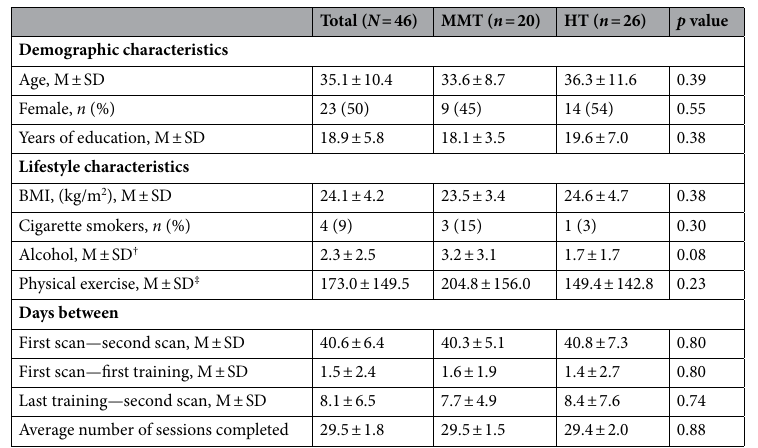
Table 1. Participant demographics, lifestyle characteristics and scanning intervals. † Serving sizes of wine (150 ml) or beer (350 ml) per week. ‡ Minutes per week. MMT Mindfulness Meditation Training, HT Health Training, BMI Body Mass